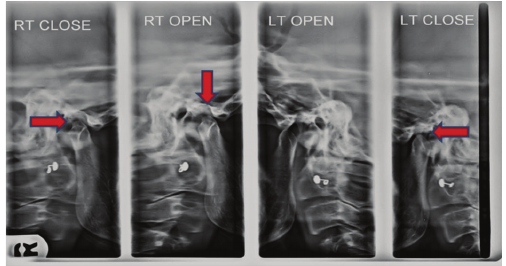
Figure7:TMJviewshowingerosivechangeswithlackofcortication of condyle and glenoid fossa with lack of translation of condyle.